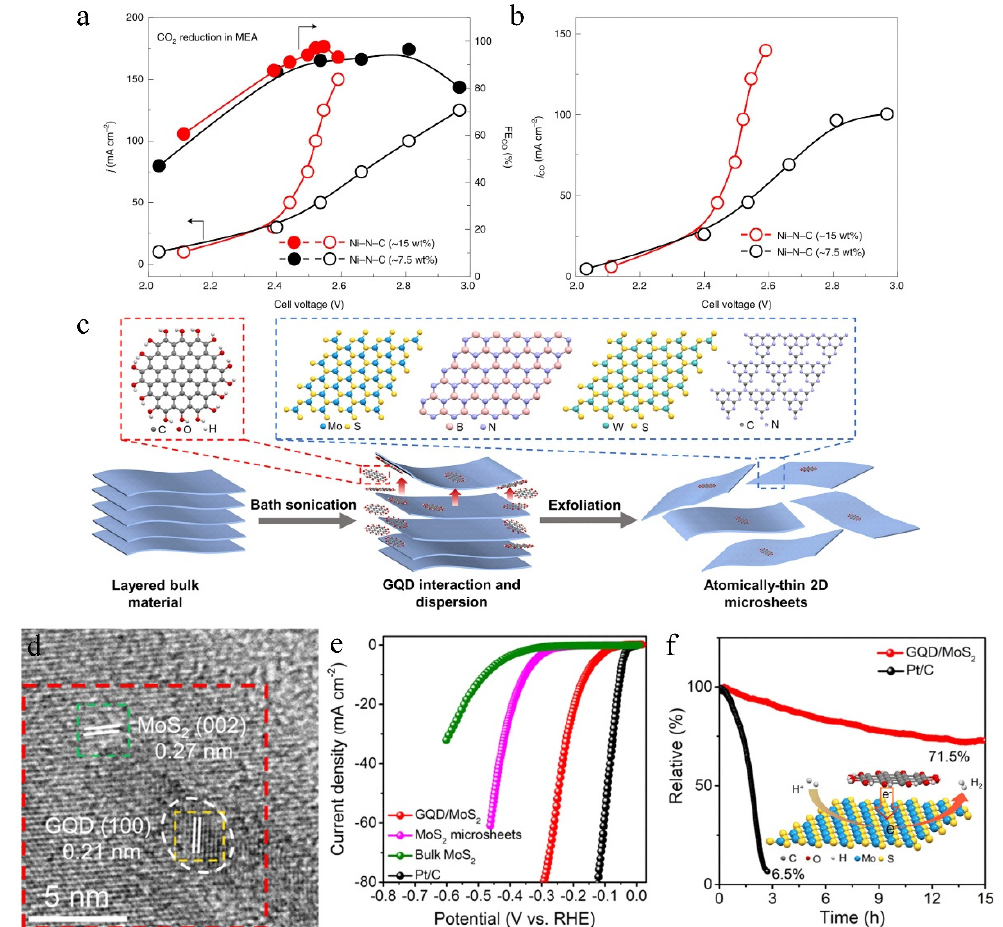
Figure 10. ( a ) The steady-state current densities and the corresponding Faradaic efficiencies of CO (FE CO ) of ~7.5 wt% Ni-N-C and ~15 wt% Ni-N-C catalyst in an anion membrane electrode assembly (MEA). ( b ) The corresponding CO partial current densities (j CO ) of ~7.5 wt% Ni-N-C and ~15 wt% Ni-N-C catalyst at different applied cell voltages. Reproduced with permission [153]. Copyright 2021, Nature Publishing Group. ( c ) Schematic illustration of GQD-assisted exfoliation of MoS 2 , h-BN, WS 2 and g-C 3 N 4 microsheets. ( d ) HRTEM images of GQD/MoS 2 . ( e ) Polarization curves of bulk MoS 2 . ( f ) Stability test of GQD/MoS 2 and Pt/C. Reproduced with permission [158]. Copyright 2021, Elsevier Ltd.